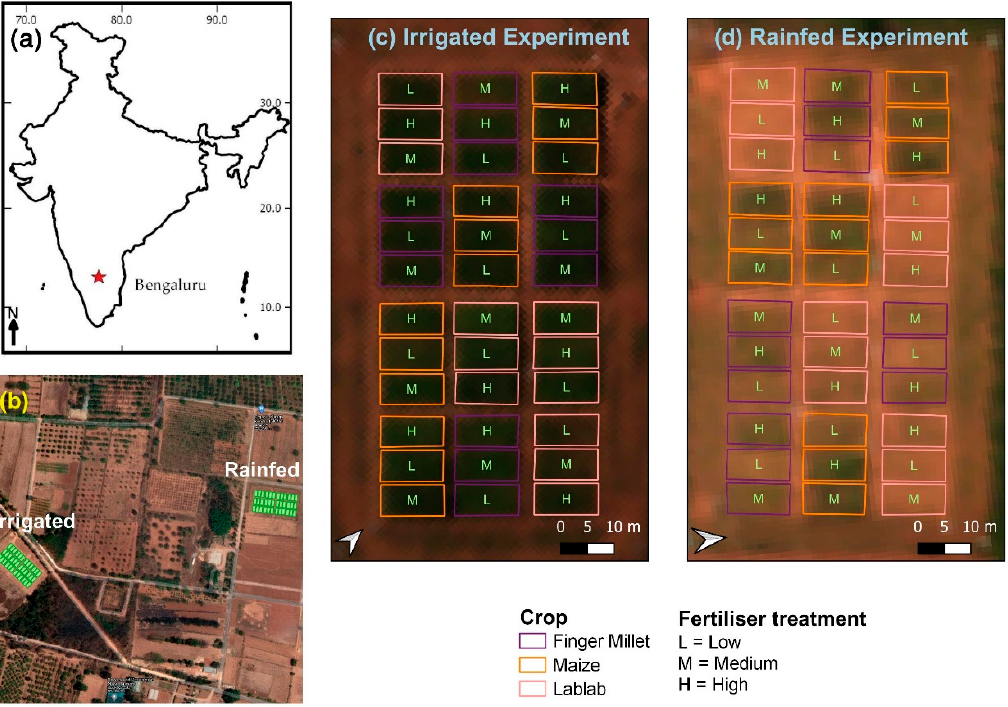
Figure 1. ( a ) Bengaluru, India; ( b ) Overview of the two experiment sites overlaid with Google satellite layer; ( c ) irrigated experiment layout, and ( d ) rainfed experiment layout with true colour composite Cubert hyperspectral image (Red = 642 nm, Green = 550 nm, Blue = 494 nm).